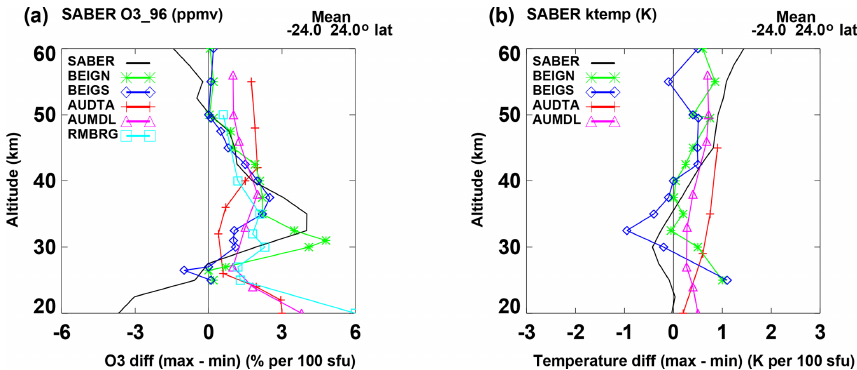
Figure 9. (a) Ozone responses versus altitude from 20 to 60km. The black line represents SABER results averaged from 24 ◦ S to 24 ◦ N; the light blue squares denote results from Remsberg (2008, RMSBRG); the green asterisks represent Fadnavis and Beig (2006), BEIGN, 0–30 ◦ N; the blue diamonds represent BEIGS, 0–30 ◦ S, HALOE data; the red plusses denote results from Austin et al. (2008) data AUDTA; the magenta triangles represents the Austin et al. (2008) model, AUMDL, 25 ◦ S to 25 ◦ N latitude composite. (b) Temperature responses corresponding to (a) .